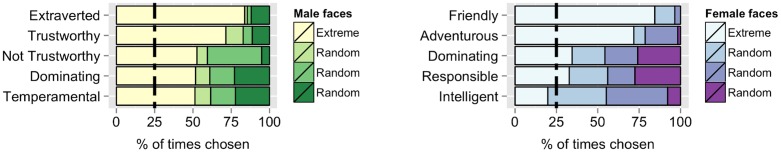
Validation of extreme faces.In the validation we presented four faces to 116 persons and asked them to choose which one they found to represent a given trait the most. The left plot shows results for the male extremes and the right results for the female extremes. The length of each section in each bar indicates the percentage of times the given face was chosen. The dotted line indicates the percentage representing a random selection of the extreme face. In all cases except one the extreme face was chosen more often than random. For the male faces we found the extremes to be chosen significantly over random. For the female faces this was only found for the Friendly and Adventurous extremes. The colours are from [33].